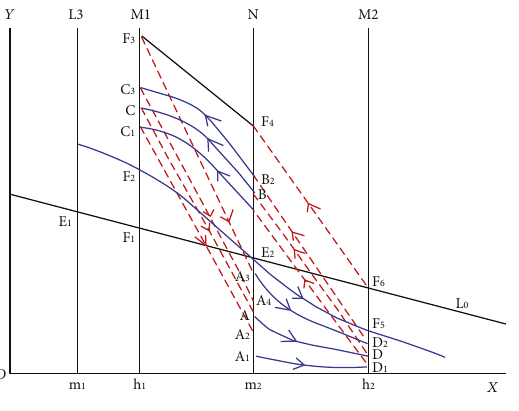
Figure 12: There exists an order-2 periodic solution of system (4) with 1 − p y